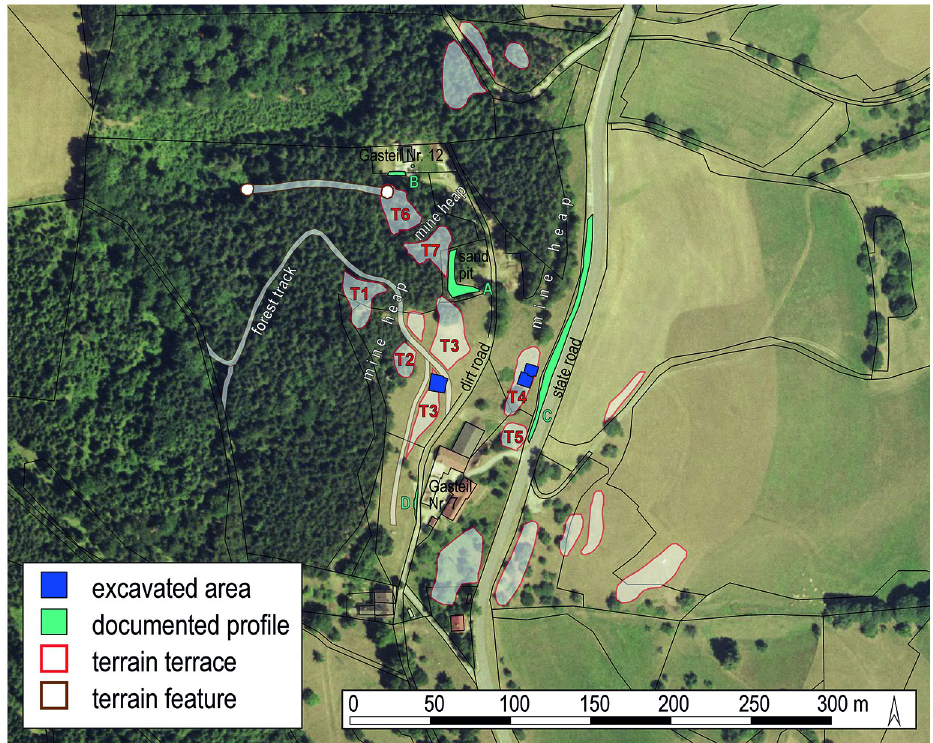
Fig 3. Aerial photograph of the excavation site. The investigated working platforms/terraces are indicated. Image: UIBK/P. Trebsche.